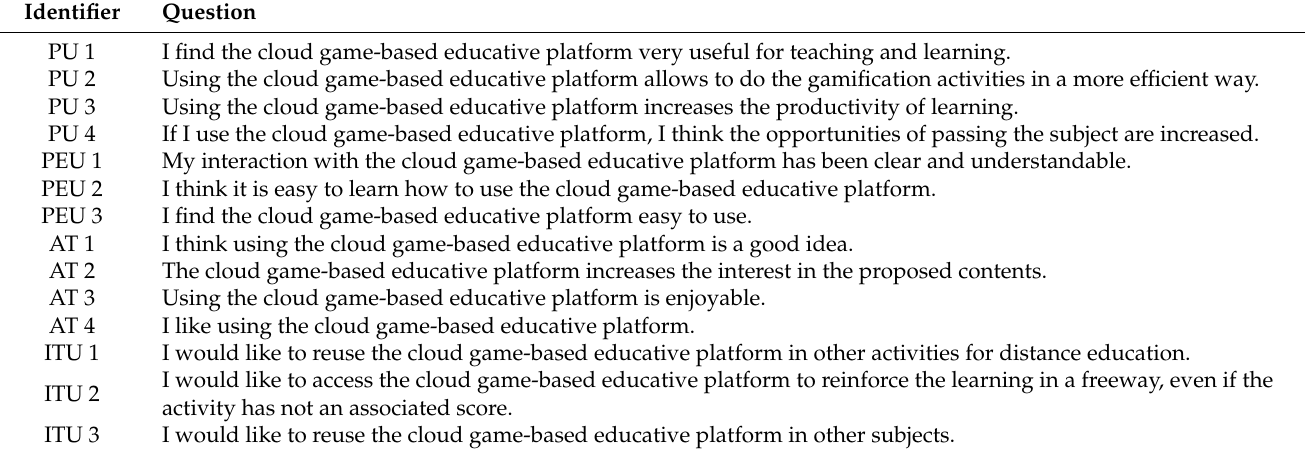
Table A1. Survey for the TAM